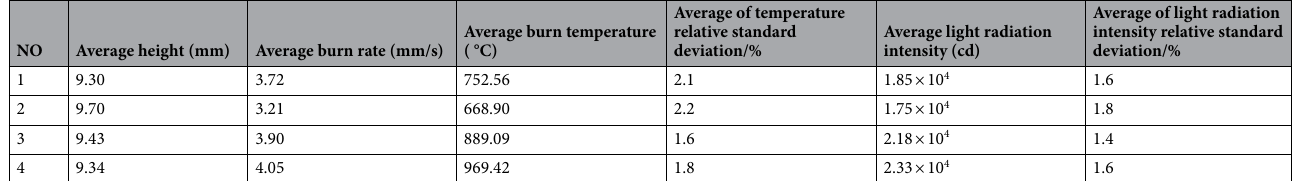
Table 3. Average optical combustion characteristics of Ba(NO 3 ) 2 /Mg with different metal